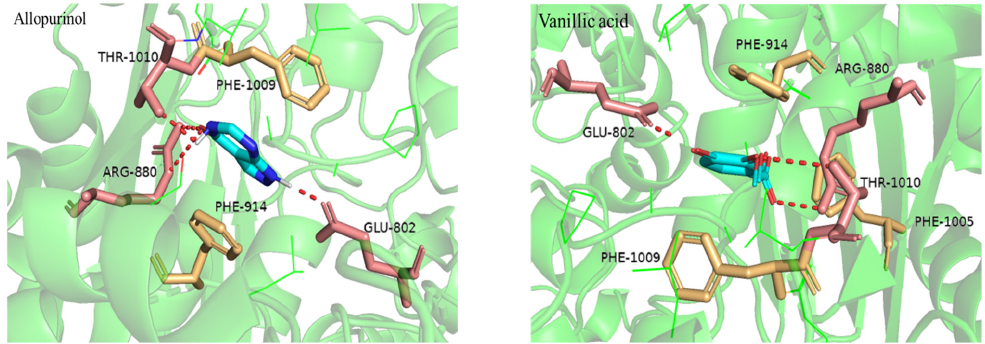
Figure 4. Xanthine oxidase and ligand molecular docking diagram.